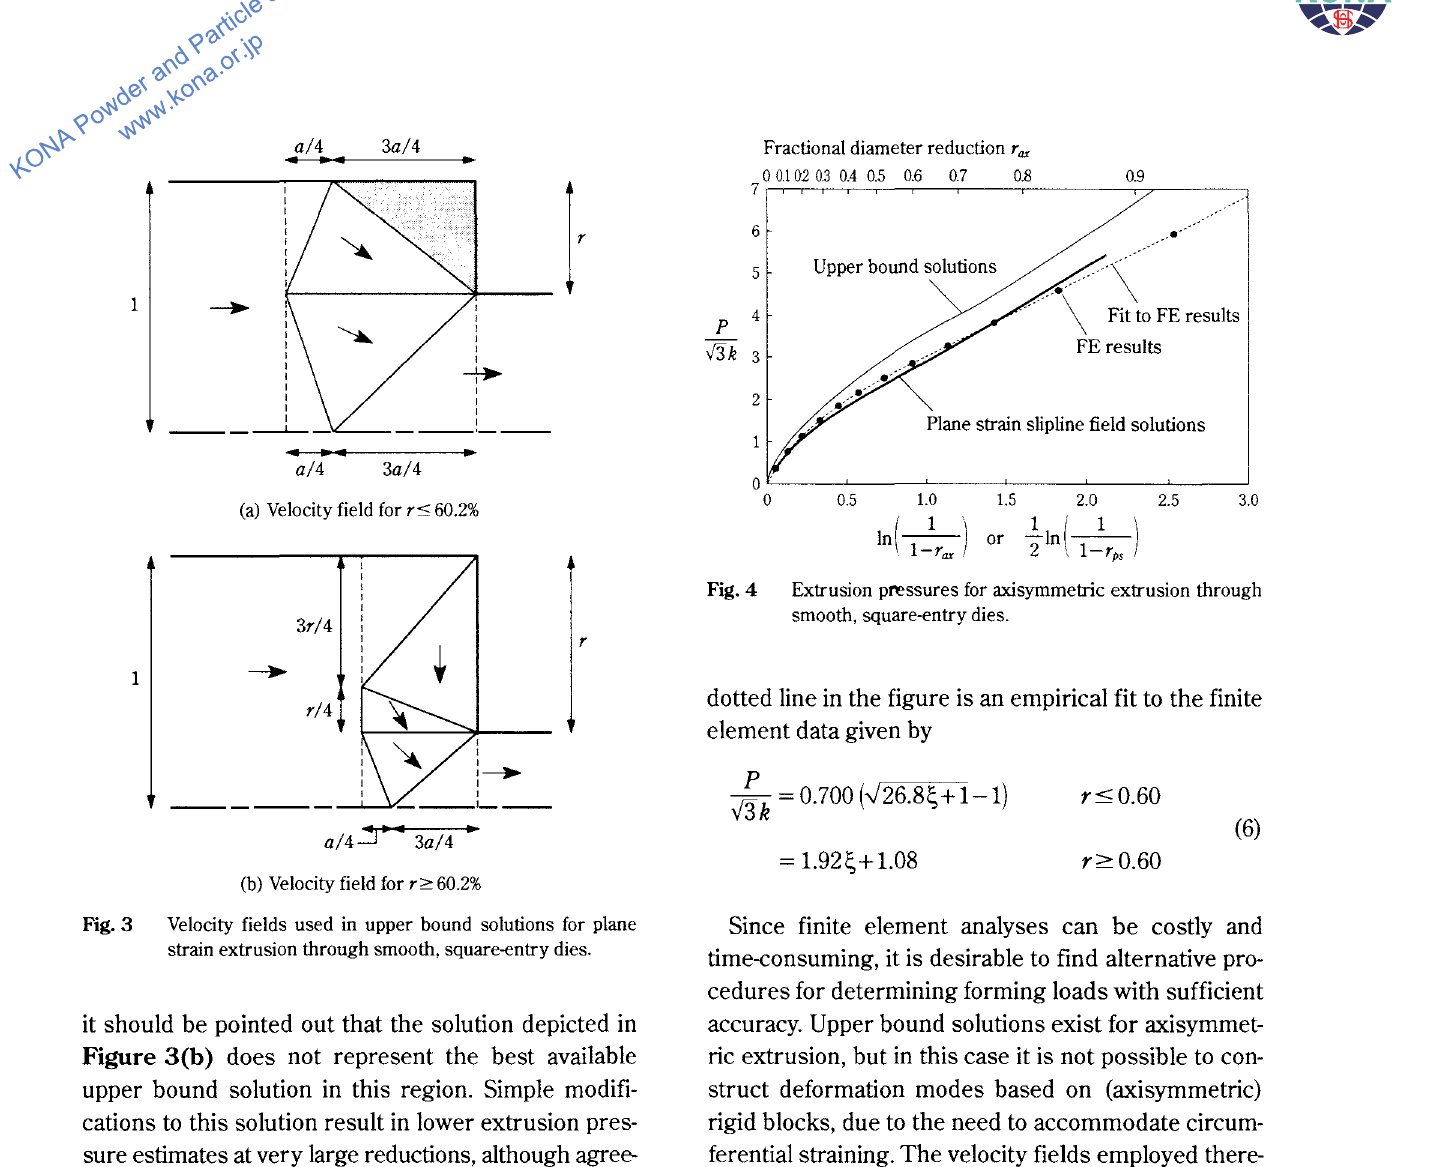
Fig. 3 Velocity fields used in upper bound solutions for plane strain extrusion through smooth, square-entry dies.